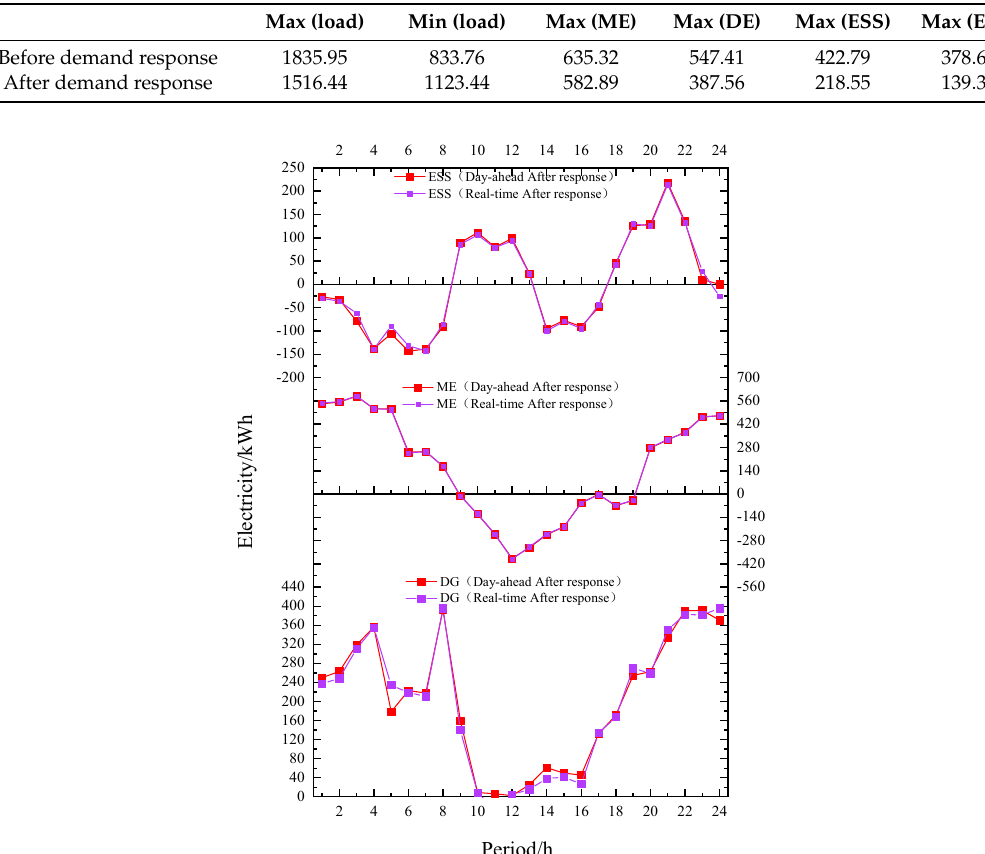
Table 6. Comparison of the key parameters before and after the implementation of demand response.